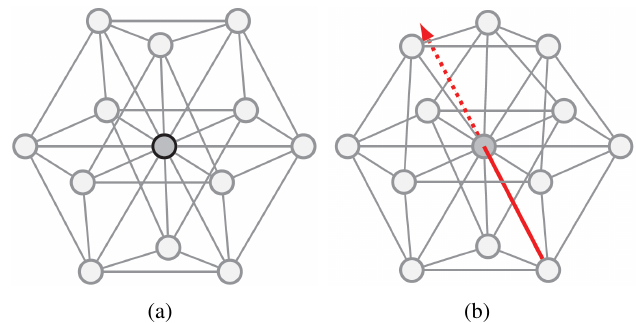
Fig. 2. The local neighbourhood in a Face Centered Cubic (FCC) arrangement is symmetric along each edge between the central cell and a neighbour (a). This is not the case for the local neighbourhood in a Hexagonal Close Packing (HCP) arrangement, which is symmet- ric only along some edges between the central cell and a neighbour (b). As a consequence, a fungal tip that grew onto the central cell from the right below (red line) would not be able to grow exactly straight ahead.